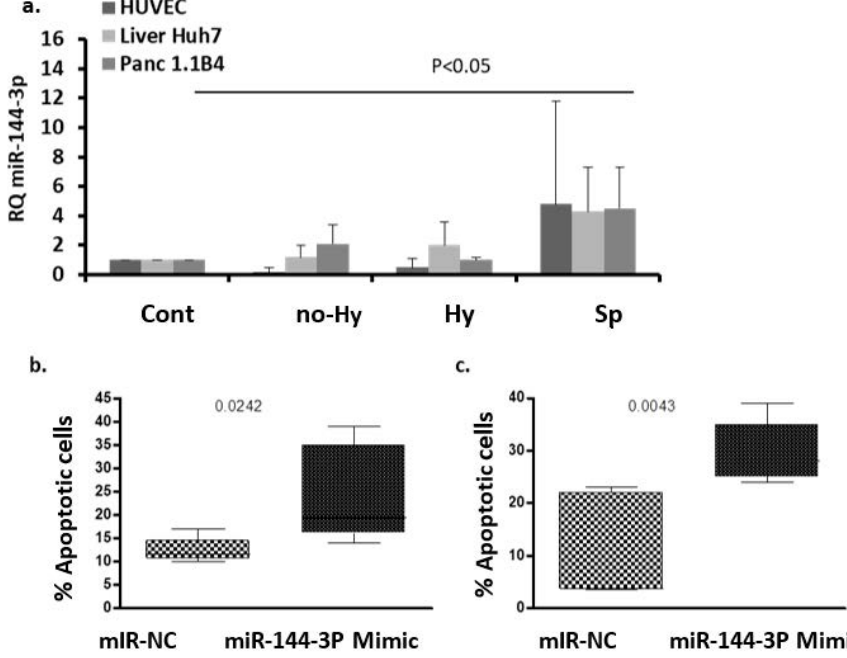
Figure 6. Extracellular vesicle (EV) effects on cell hsa-miR-144-3p expression. ( a ) Relative quan- tification of hsa-miR-144-3p in human umbilical vein endothelial cells (HUVECs), Huh7 cells, and 1.1B4 cells. The results were normalized to U6 small RNA expression and to cells after stimulation with EVs of the control group (N = 4–8). ( b , c ). MiR-144-3p mimic effect on cell apoptosis using the TUNEL assay. The assay was performed on liver Huh7 cells ( b ) and pancreatic 1.1B4 cells ( c ) after 24 h transfection with 30 nM miR-144-3p mimic or non-targeting negative control (miR-NC). The results are presented as the percentage of apoptotic cells of the total cell population; the data are displayed as median (horizontal bar), range from the 25th to 75th percentile (box), and extremes of distribution from 10th and 90th percentiles (error bar).